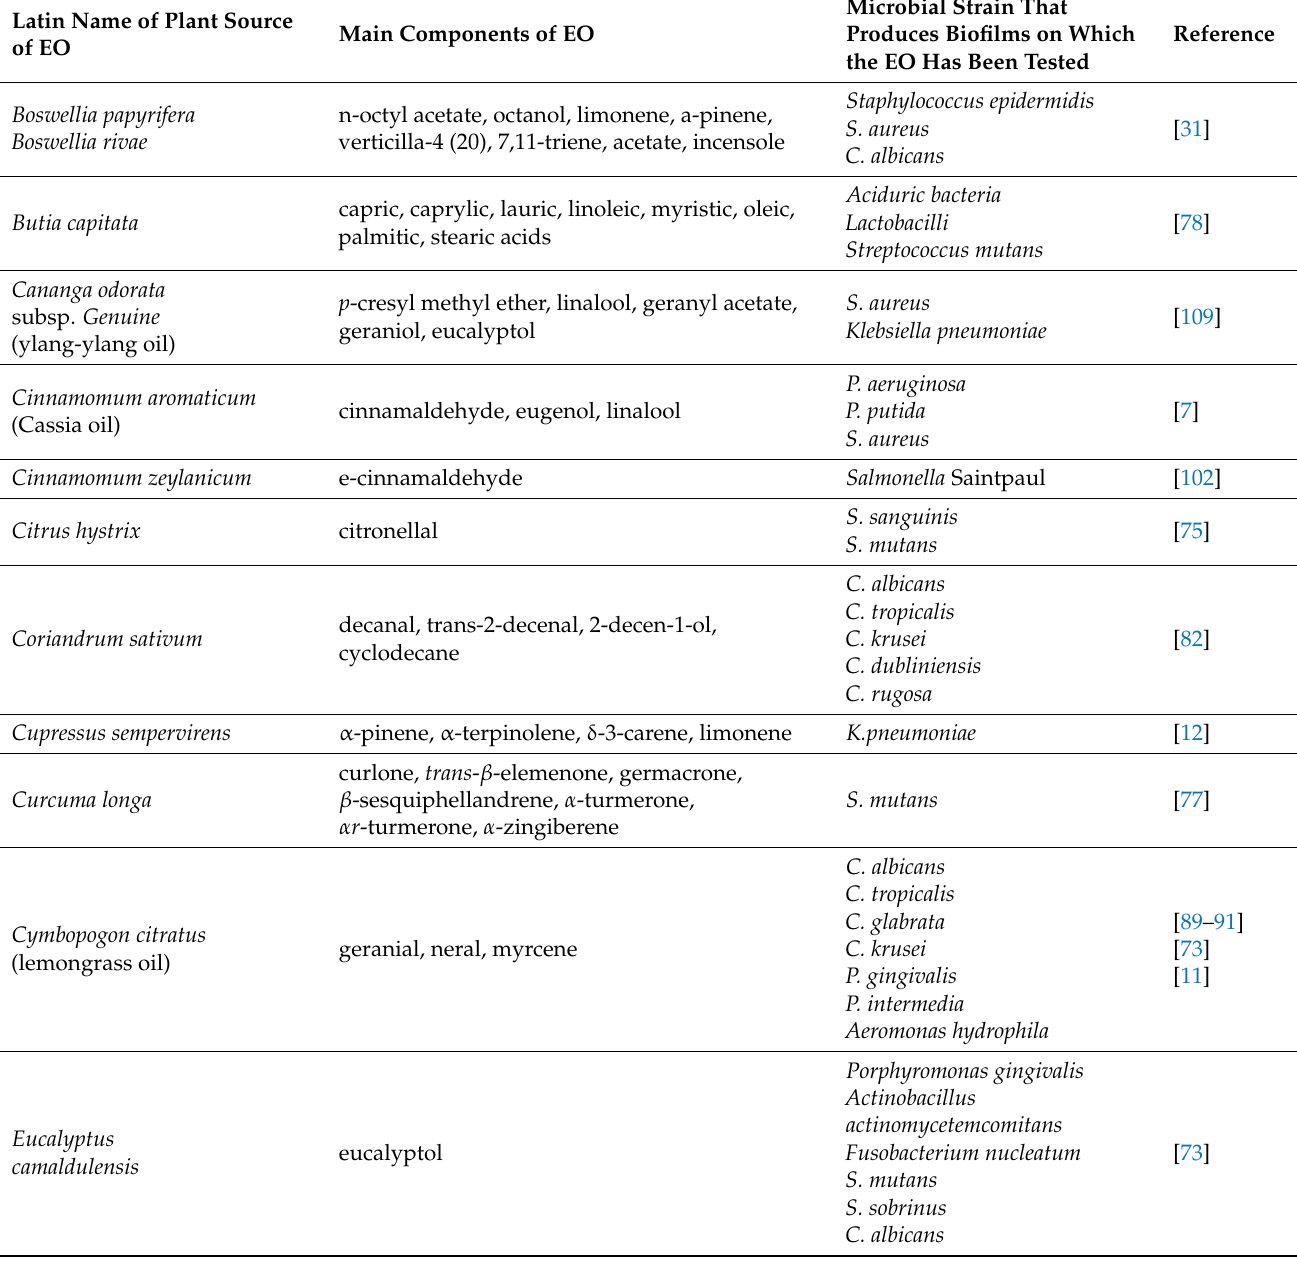
Table 1. The EOs studied in terms of microbial antibiofilm